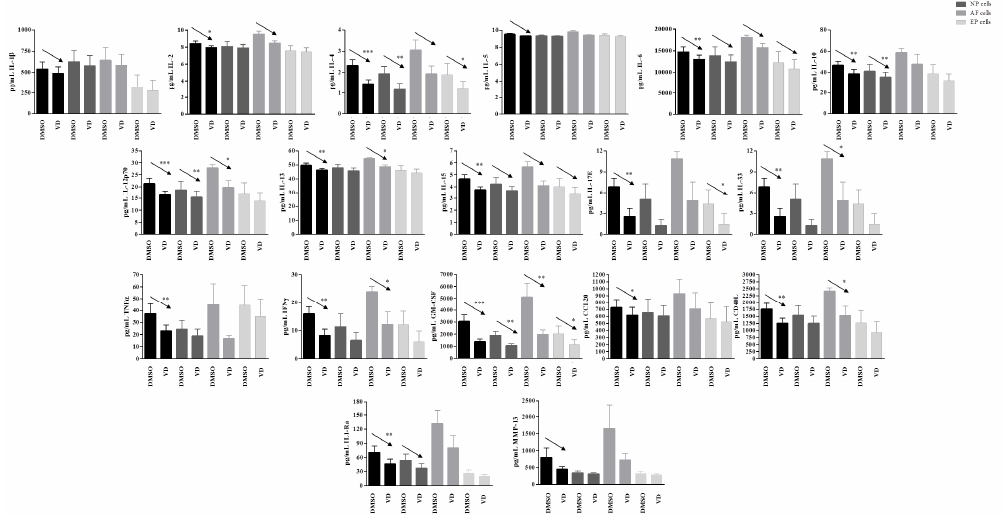
Figure 9. Levels of specific proteins secreted by pooled, NP, AF, and EP cells of seven donors in inflamed condition. Arrows indicate significant differences and tendencies in protein secretion of vitamin D treated cells in comparison with untreated cells. * p ≤ 0.05, ** p ≤ 0.01, *** p ≤